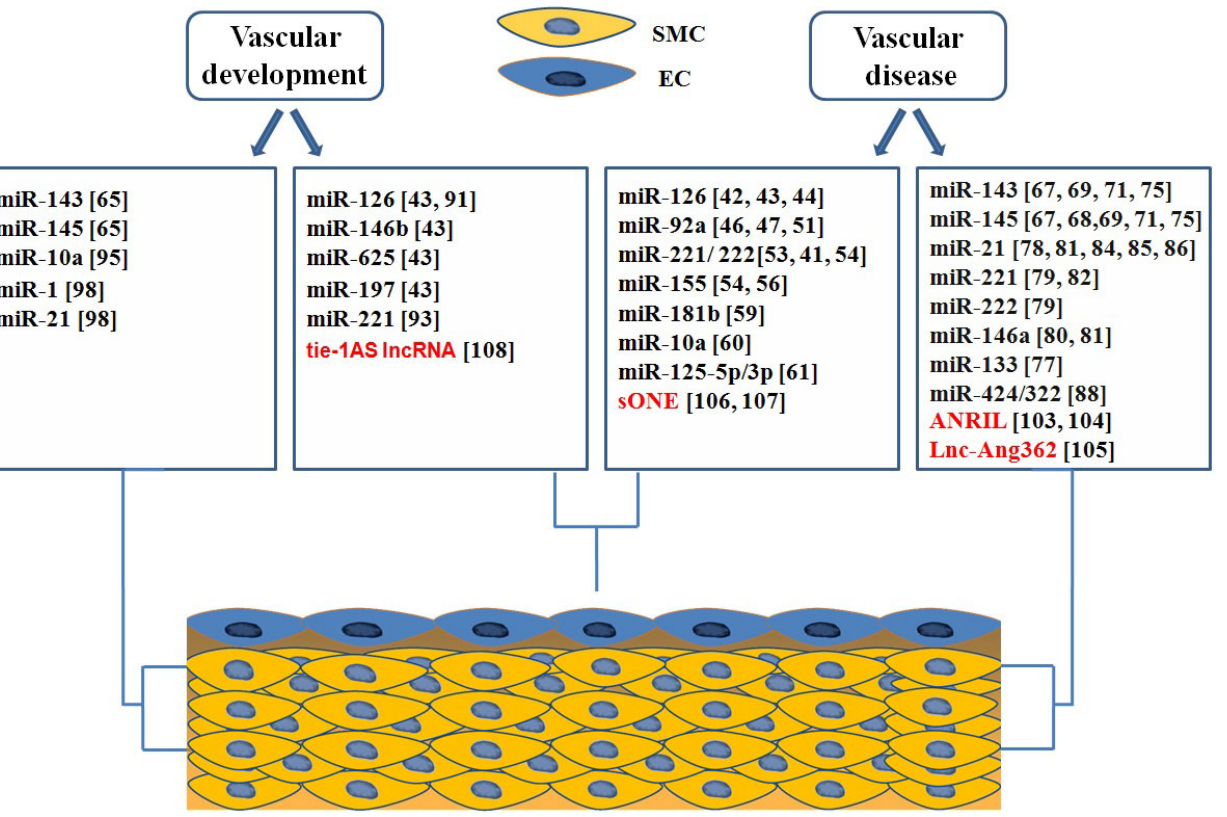
Figure 1. Role of non-coding RNAs in Vascular Development and